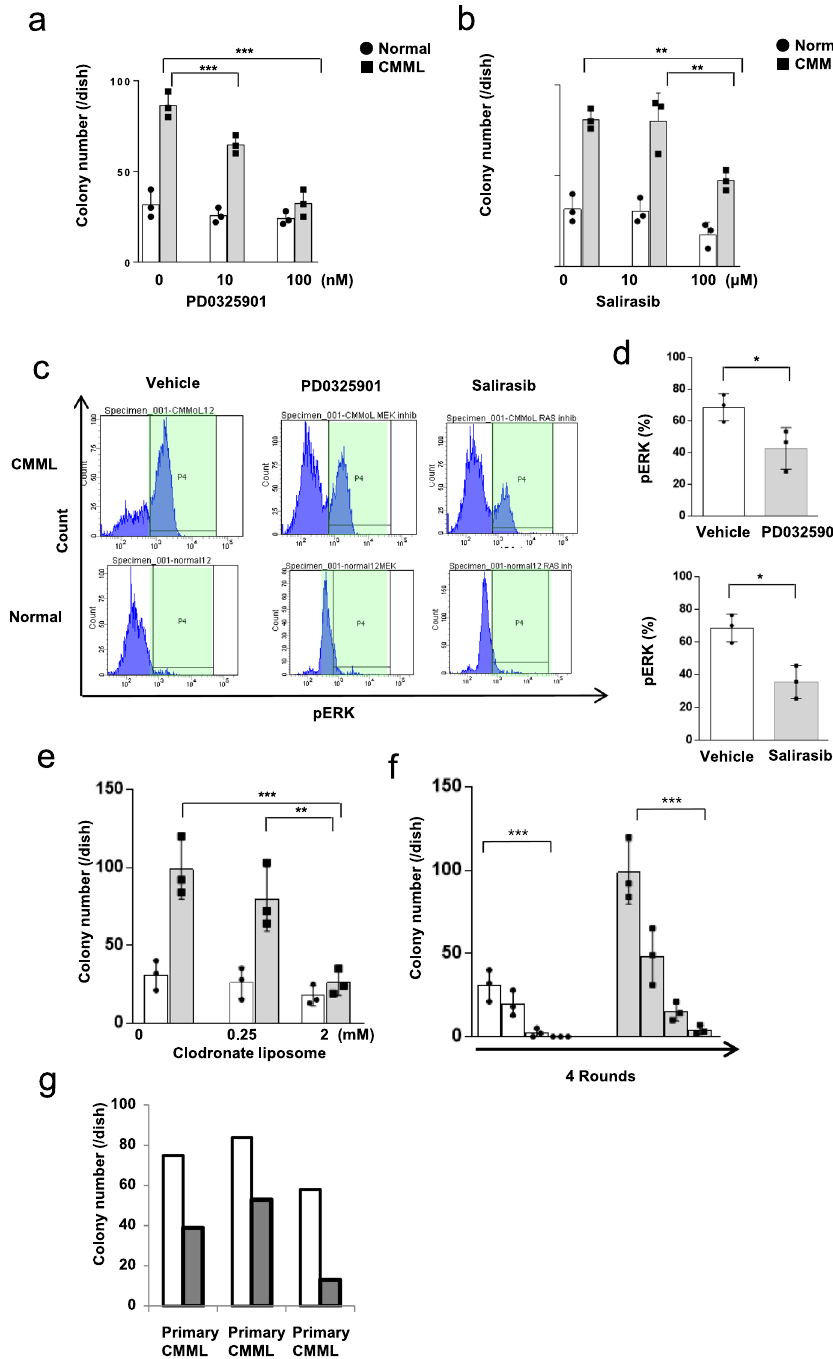
Figure 5. Drug discovery using CMML-iPSCs. ( a ) An MEK inhibitor (PD0325901) reduced the colony- forming capacity of CMML iPSC-derived HPCs ( n = 3, independent experiments,, Normal-iPSCs1 from a healthy donor, and CMML-iPSCs1 from a CMML patients, Experiments were performed in triplicate. Statistical analyses were performed with ANOVA and the Dunnett post-test for multiple comparisons. *** p < 0.001)). ( b ) RAS inhibitor (salirasib) reduced the colony-forming capacity of CMML iPSC-derived HPCs ( n = 3, independent experiments, Normal-iPSCs1 from a healthy donor, and CMML-iPSCs1 from a CMML patients, Experiments were performed in triplicate. Statistical analyses were performed with ANOVA and the Dunnett post-test for multiple comparisons. ** p < 0.01). ( c ) pERK was constitutively activated only in the colonies of CMML iPSC-derived HPCs. Furthermore, ERK phosphorylation was inhibited by MEK and RAS inhibitors in these colonies. ( d ) The expression level of pERK was significantly decreased in CMML-iPSC-derived hematopoietic colonies by MEK or Ras inhibitor ( n = 3, independent experiments, * p < 0.05, Normal-iPSCs1 from a healthy donor, and CMML-iPSCs1 from a CMML patients, paired two-sided t -test). ( e ) Liposomal clodronate suppressed the growth of colonies from CMML iPSCs. Statistical analysis was performed ( n =